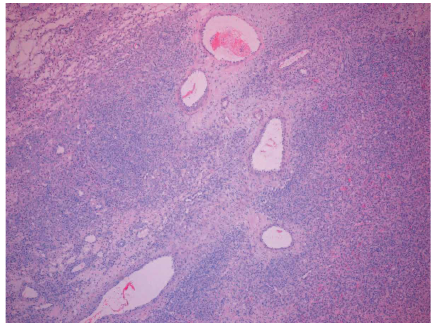
Figure 5: (40x, H&E) Prominent vascularity.